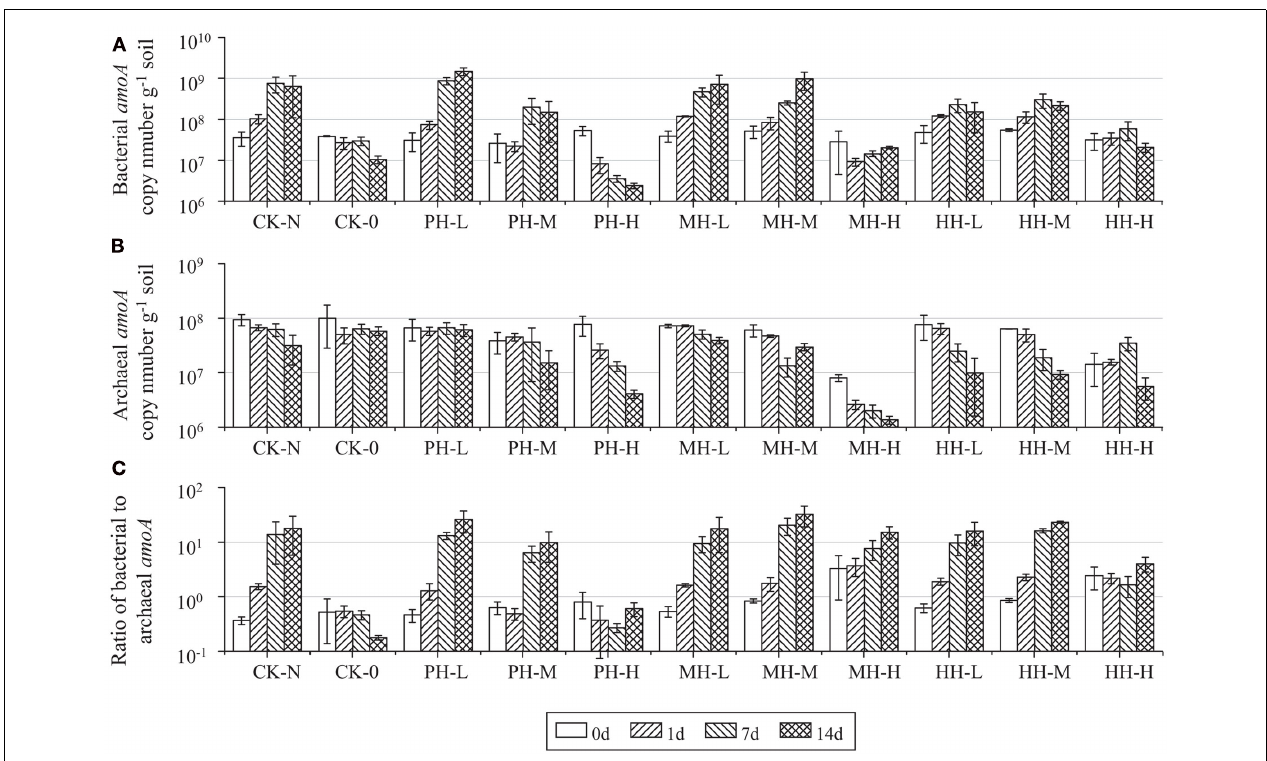
FIGURE 2 | Changes of bacterial amoA copy number (A), archaeal amoA copy number (B), and of bacterial to archaeal amoA ratio (C) in the soil microcosm incubated for 14days. All designations are the same as those in Figure 1